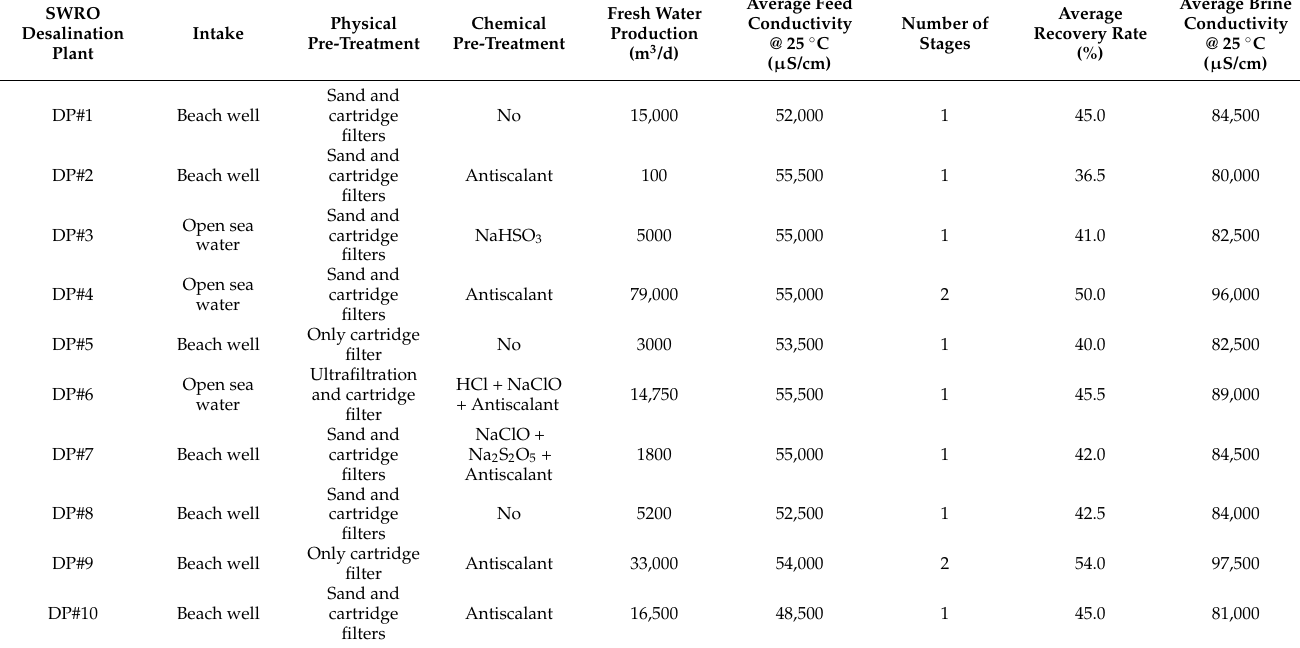
Table 2. Characteristics of the seawater reverse osmosis (SWRO) desalination plants